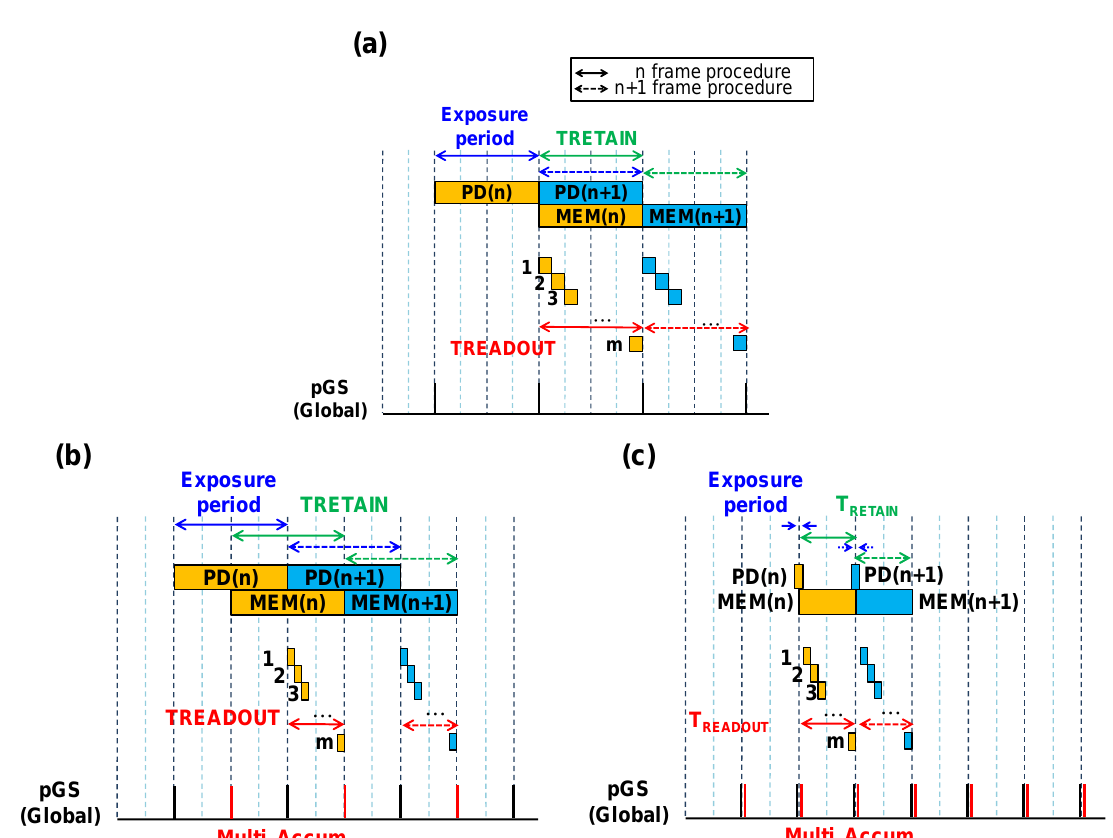
Figure 6. Signal readout procedure of ( a ) the conventional; ( b ) the multiple accumulation of seamless and ( c ) the multiple accumulation of non-seamless.